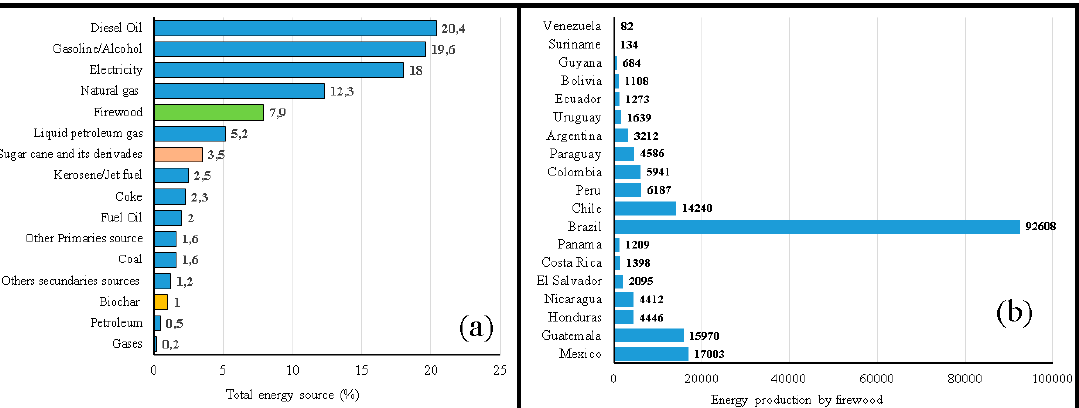
Figure 2. ( a ) Percentage of the energy production generated by the different energy sources used and ( b ) percentage of energy production by firewood in Latin America [40].